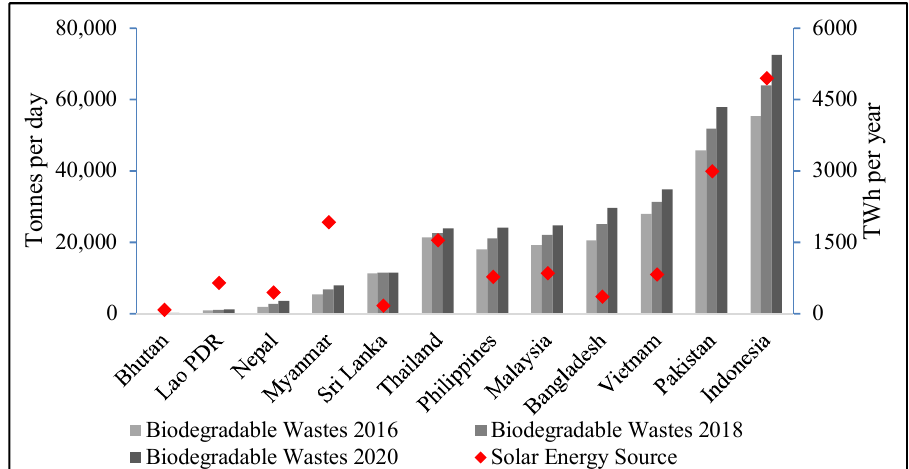
Figure 11. Projected biodegradable waste generation and solar energy resources in Asian developing countries [2,44].